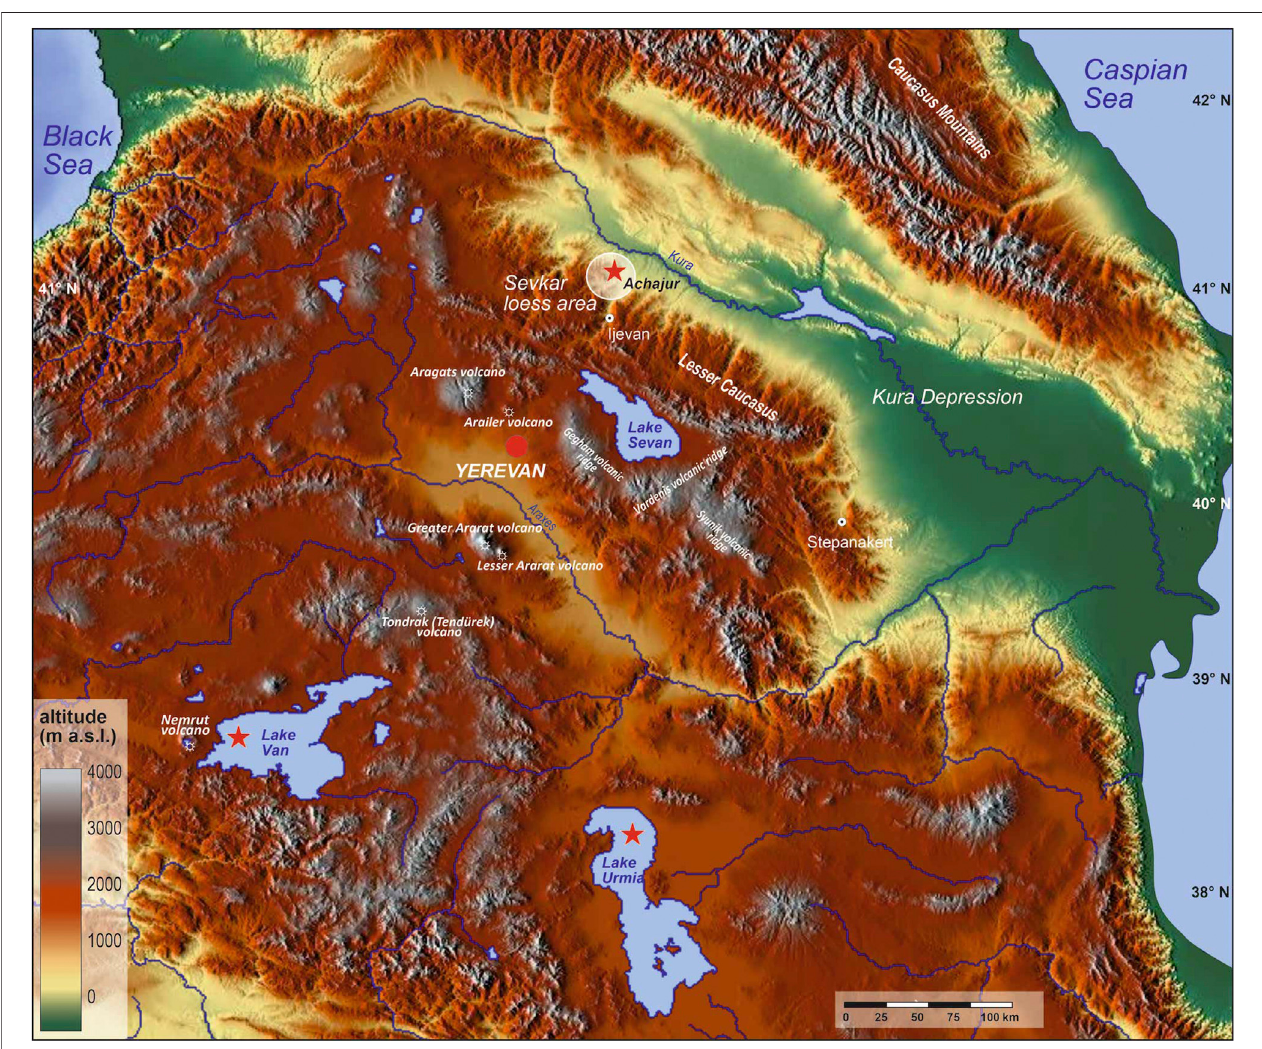
FIGURE 1 | Study area showing the location of the Achajur section and sites of important palynological studies discussed for palaeoclimatic interpretation. (Map modi fi ed from maps-for-free.com).